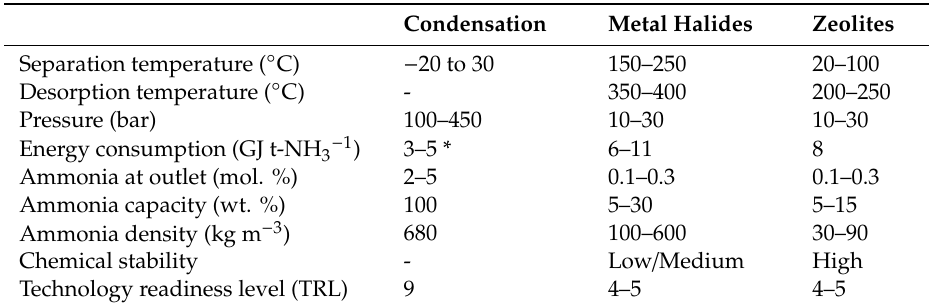
Table 2. Comparison of ammonia separation technologies. Based on references [16,80–83]. * The energy consumption increases to 20–25 GJ t-NH 3 − 1 at 20 bar